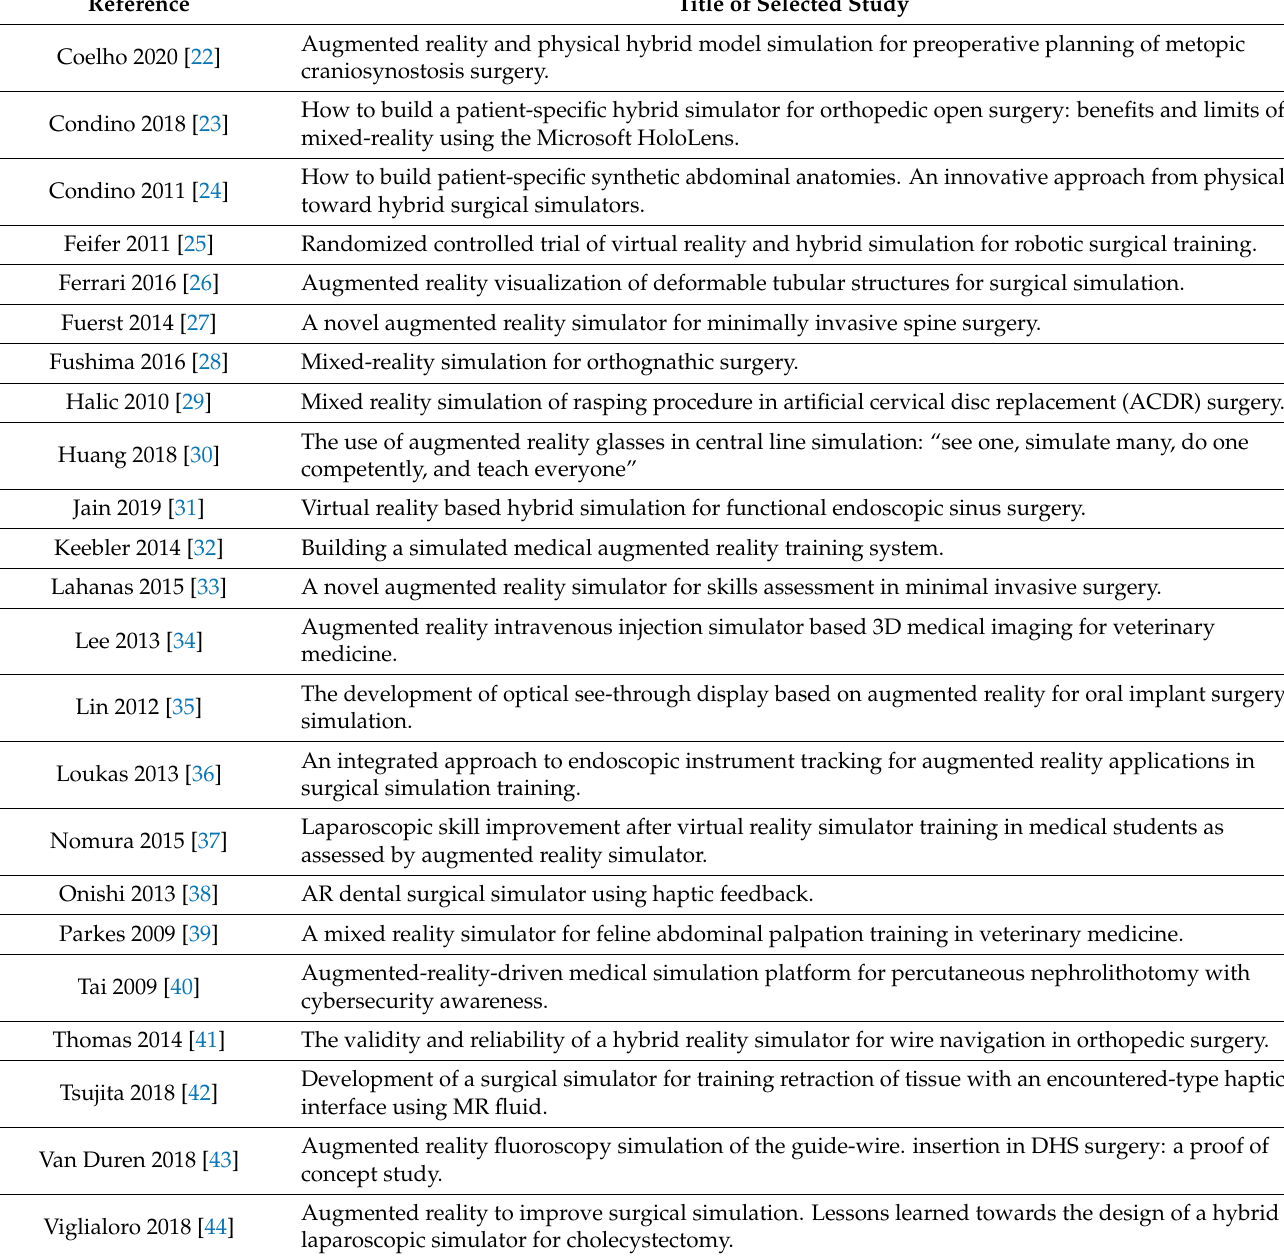
Table 2. Selected